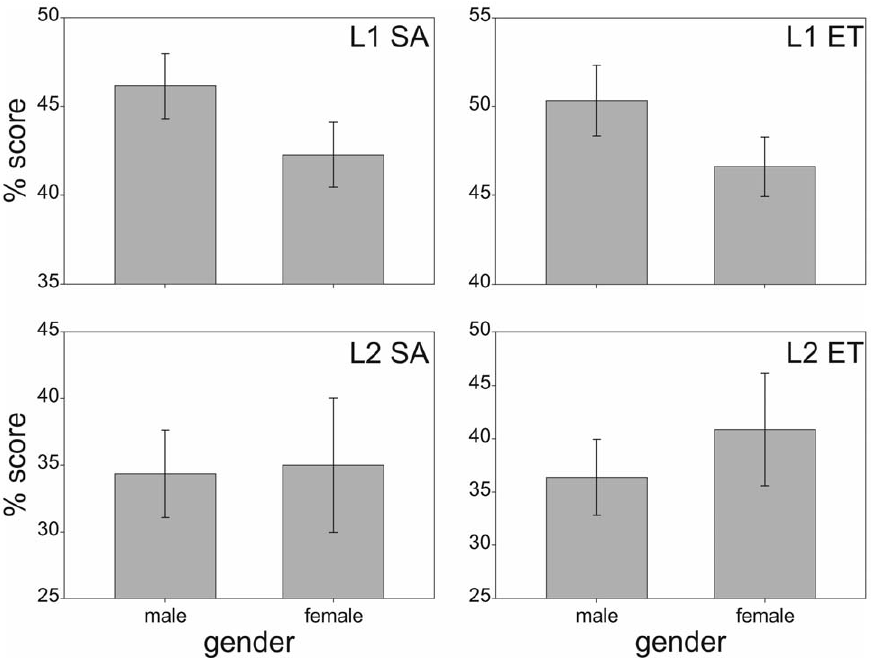
Figure 2. Mean ( ± standard error SE) of overall test score performances by gender: (top left) L1 SA MCQ, (top right) L1 ET MCQ, (bottom left) L2 SA MCQ, and (bottom right) L2 ET MCQ.